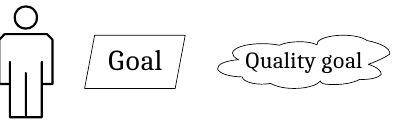
Figure 4. Selection of AOM notation